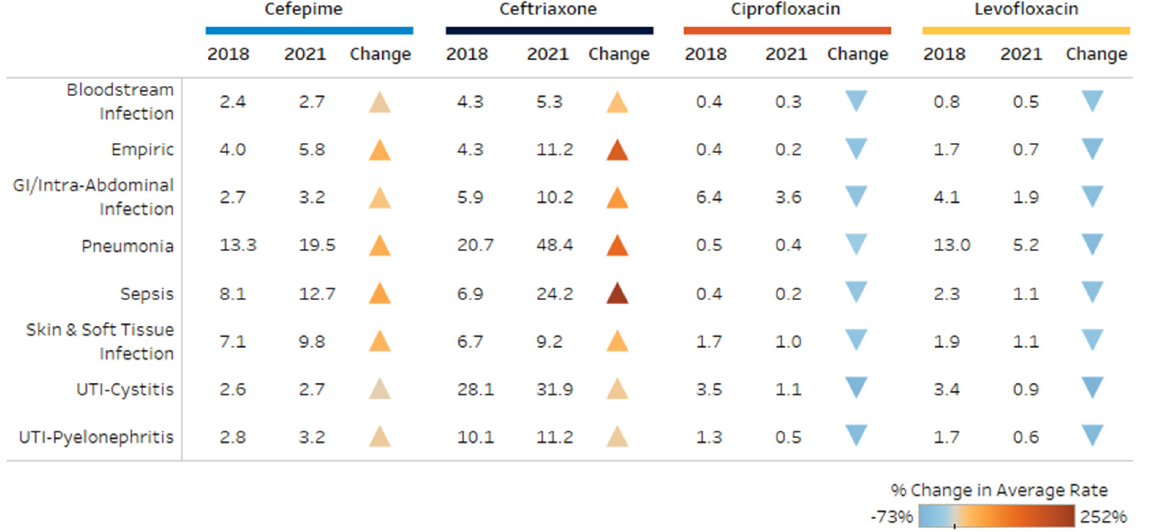
Figure 4. Change in use (DOT per 1000 patient days) for top indications.